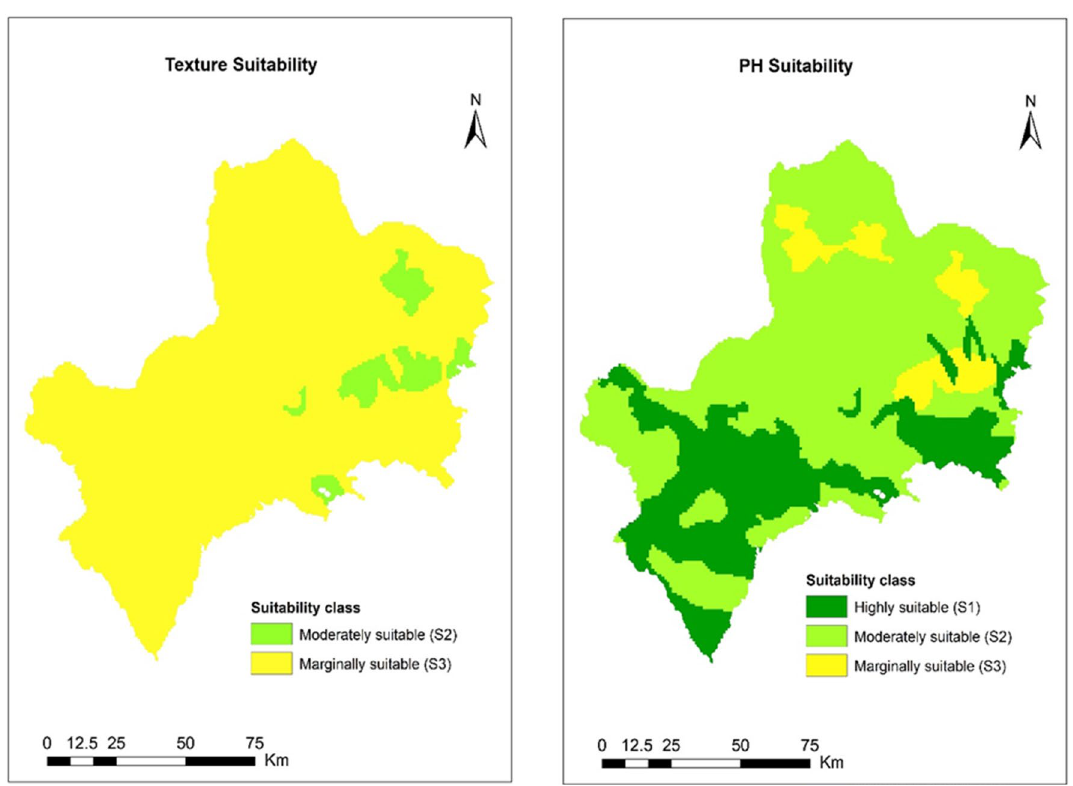
Fig. 4 Soil texture and soil pH suitability